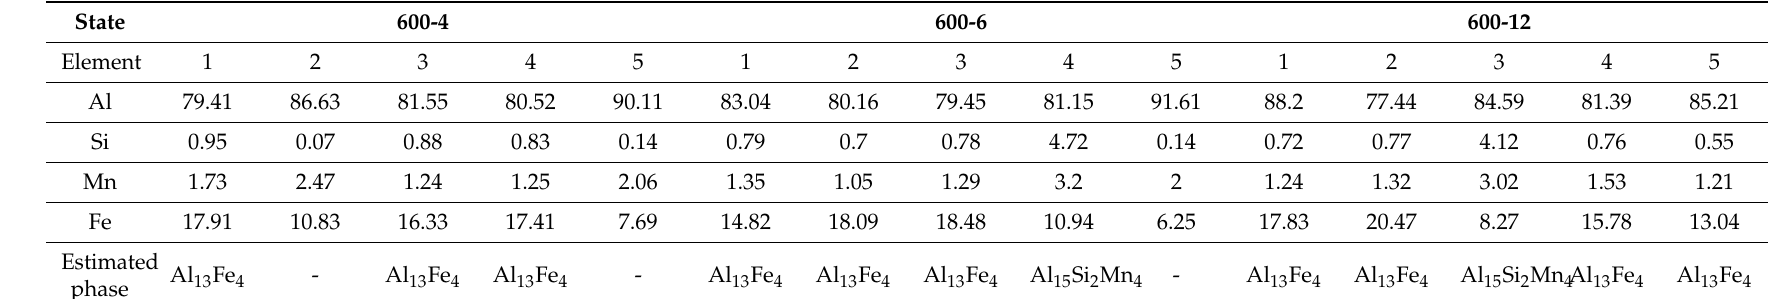
Table 4. EDS results showing di ff erent phases present in the investigated samples from Figure 8 in at.